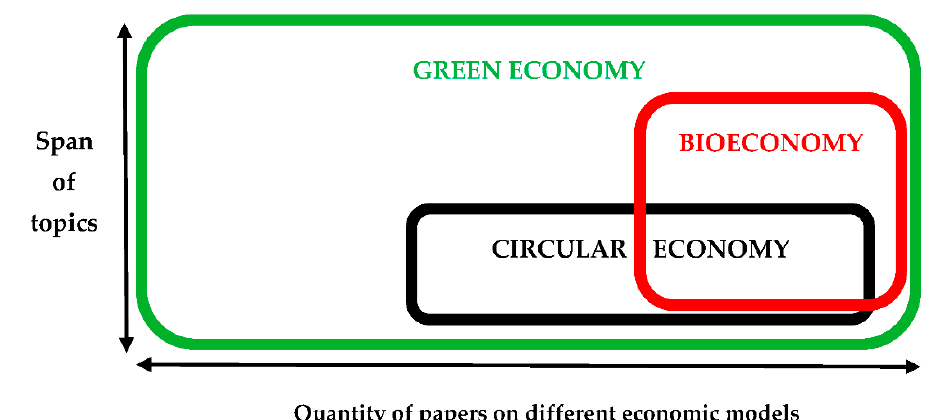
Figure 5. Visualization of the relative representation of the three economic models under consideration in the relevant literature in quantitative and qualitative dimensions. Legend: the sizes of figures above show relative dissimilarities only. Source: designed by authors based on sources referenced in the present article and data displayed in Figure 2 above.